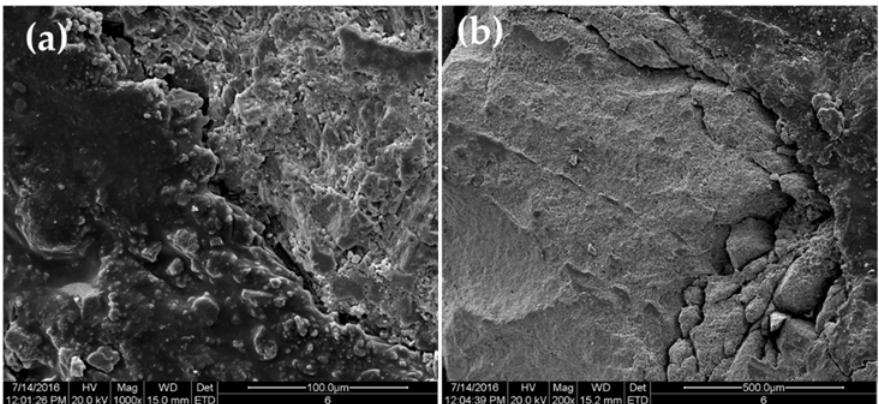
Figure 8. SEM images of asphalt–aggregate interfaces: ( a ) asphalt–steel slag interface and ( b ) asphalt–limestone interface.